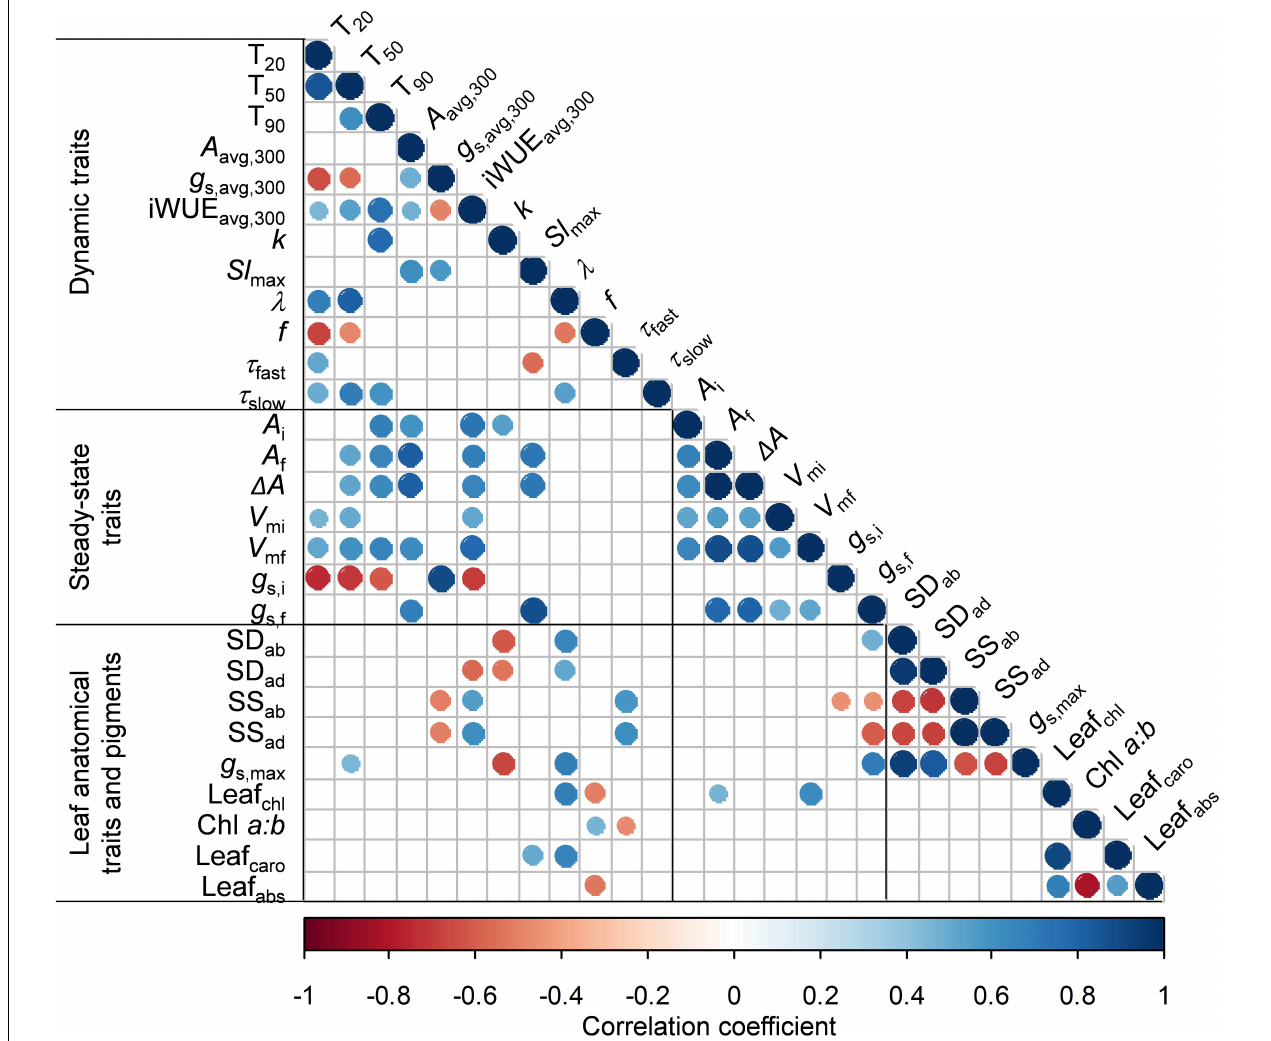
FIGURE 7 | Correlation matrix among all traits measured in this study. Statistically significant ( p < 0.05) negative linear correlations are shown in red, significant positive correlations are shown in blue, insignificant correlations are left blank. For definitions and units, refer to Table 2 . Correlation coefficients and p -values for each correlation are given in Supplementary Table 3